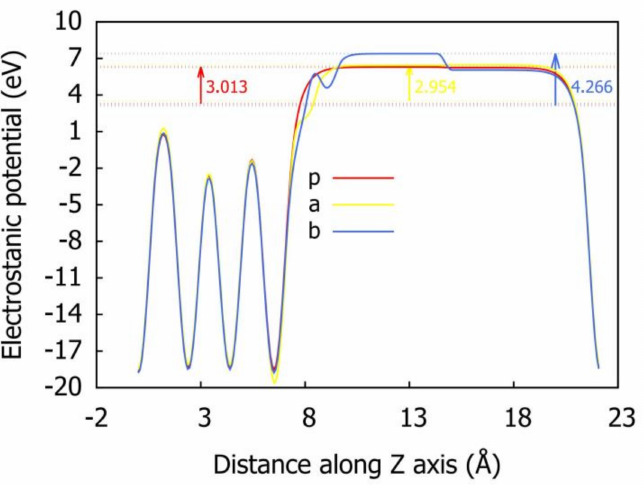
Figure 15. The variation of electrostatic potential distance along z axis before and after co-adsorption. (p: pure δ -Pu (100) surface, a: BH-S-H4O10 configuration, b: B-S-H2O4 configuration). E vacuum : the distance between H atom and O atom, E Fermi : Fermi level, φ : surface work function ( φ =E vacuum - E Fermi ), ∆ φ : the difference of surface work function between adsorption configuration and pure δ -Pu (100)